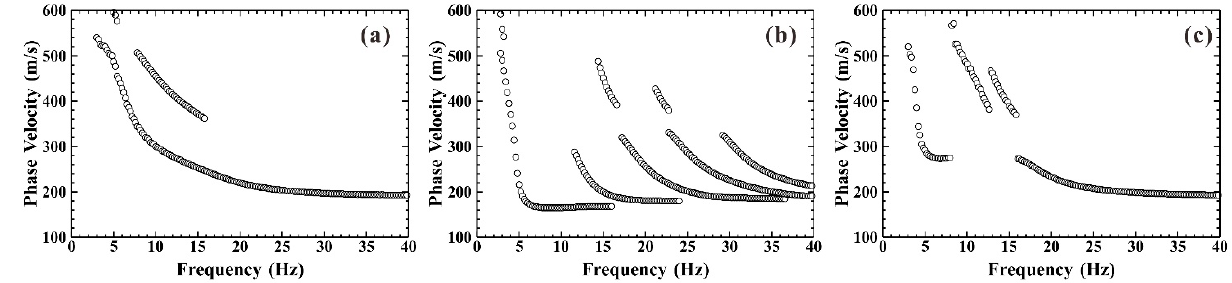
Figure 5. The dispersion curves detected from Rayleigh wave dispersion diagram. ( a ) Model 1; ( b ) Model 2; ( c ) Model 3. Table 2. Search intervals of S-wave velocity and layer thickness during inversion.